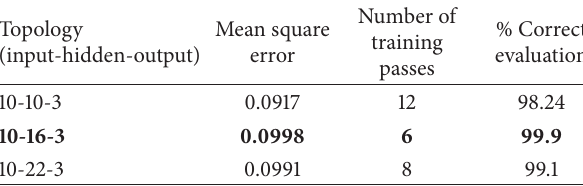
Table 3: Topology of tested